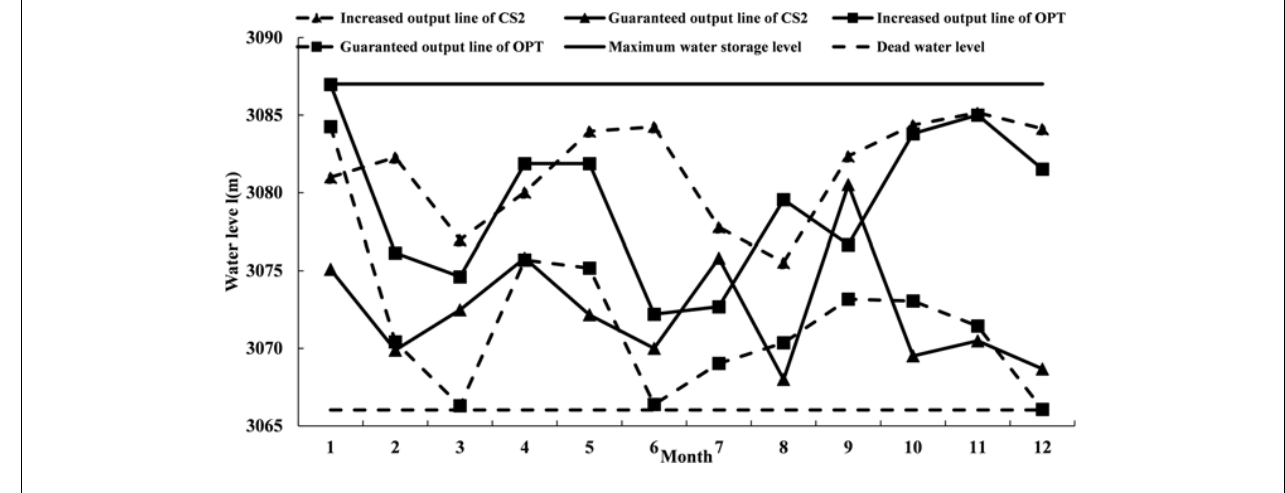
FIGURE 9 | Comparison of power generation rules between OPT and CS2.